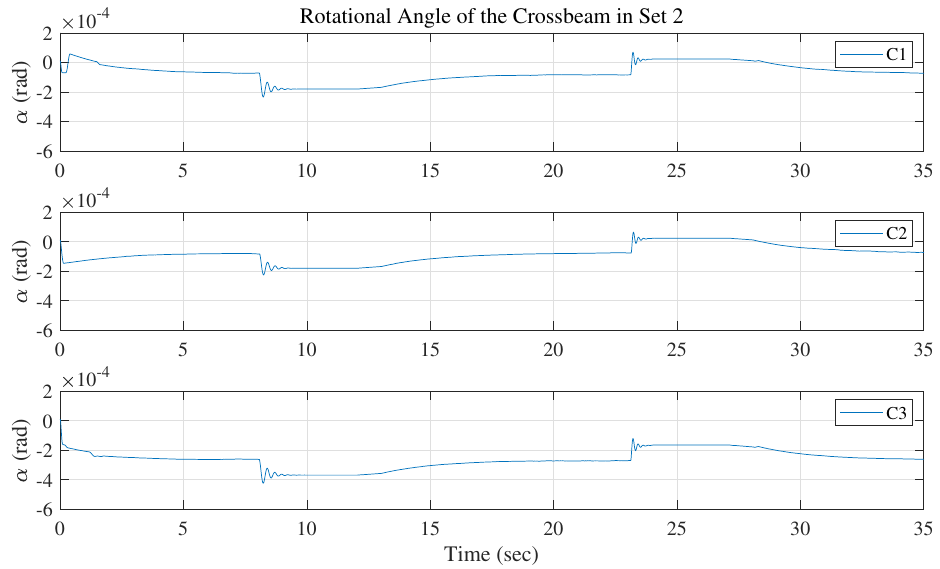
Figure 13. Rotational angles comparison in Set